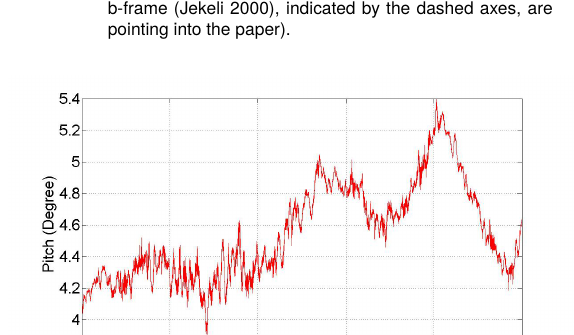
Figure 5. Adiagramoftheleverarm(theDowndirectionofnavigation frame, indicated by the solid axes, and the z-axis of the b-frame (Jekeli 2000), indicated by the dashed axes, are pointing into the paper).